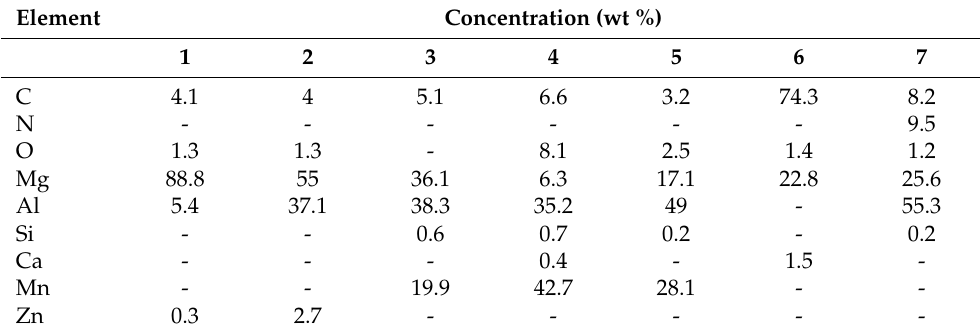
Table 3. Composition from EDX analysis of positions marked on Figure 2.